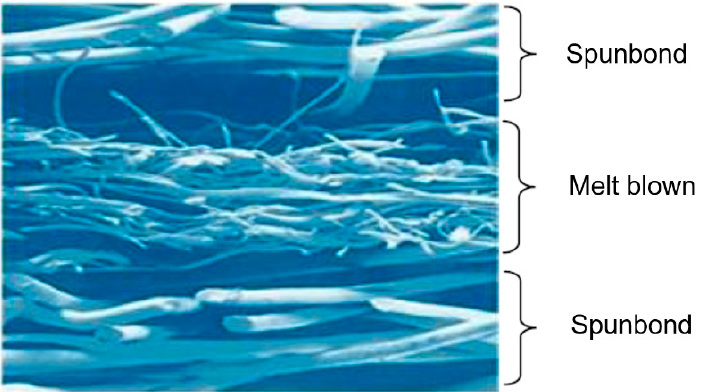
Figure 2. Typical microscopic image of a web representing the large fibers as spunbond and small fibers as meltblown [33].